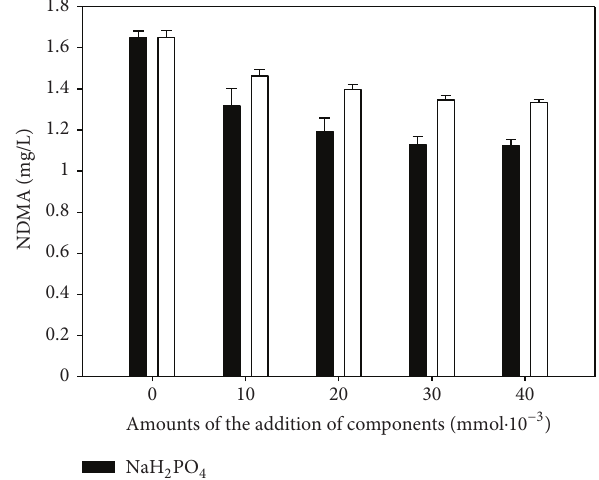
/NaOH buffer is 2.8 times